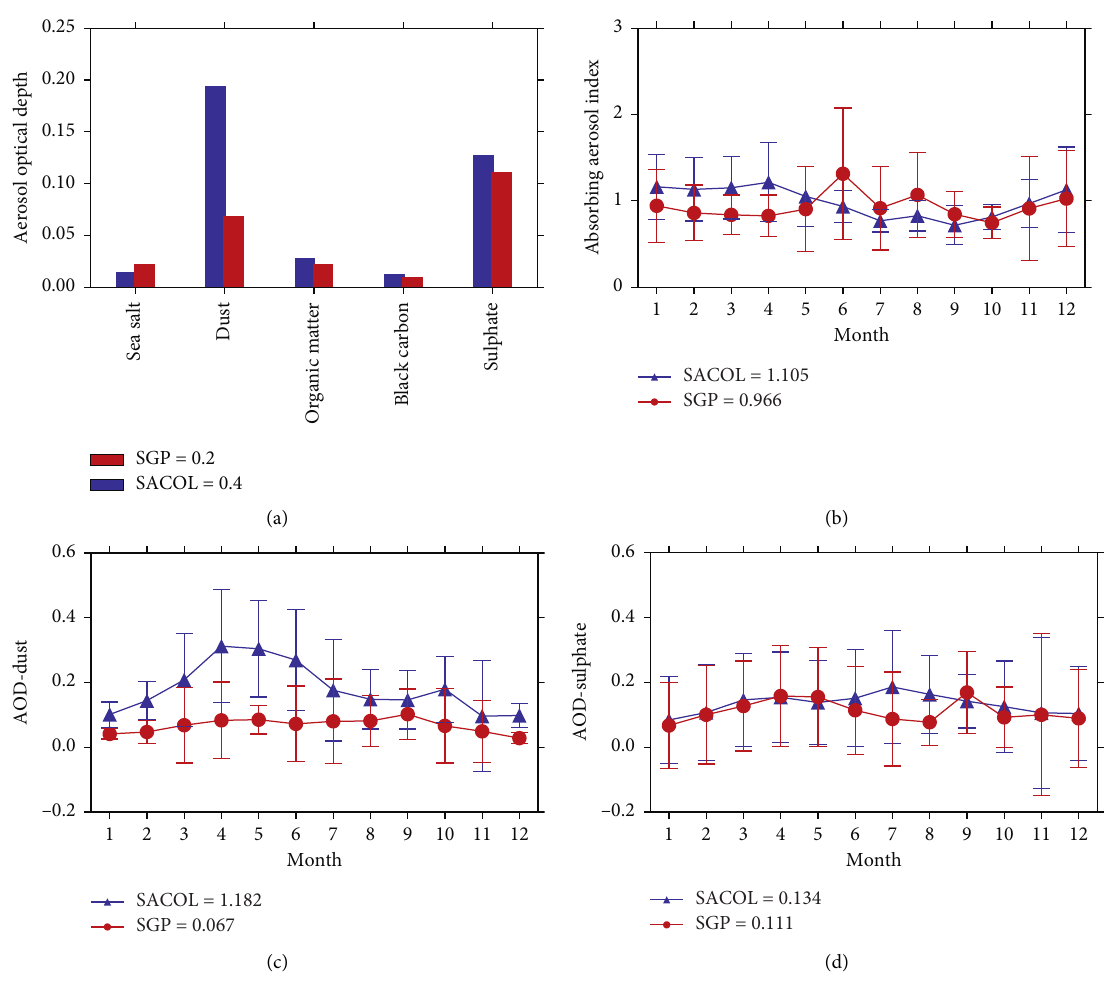
Figure 3: (a) Aerosol optical depth for different aerosol types from the MACC reanalysis (2003–2015) and monthly mean absorbing aerosol index from the OMI (2004–2015) (b), aerosol optical depth of dust (c), and sulphate (d) from MACC at the SGP (in red) and SACOL (in blue) sites. The total AOD at each site is given in the upper right corner of (a). Error bars in (b-d) show the standard